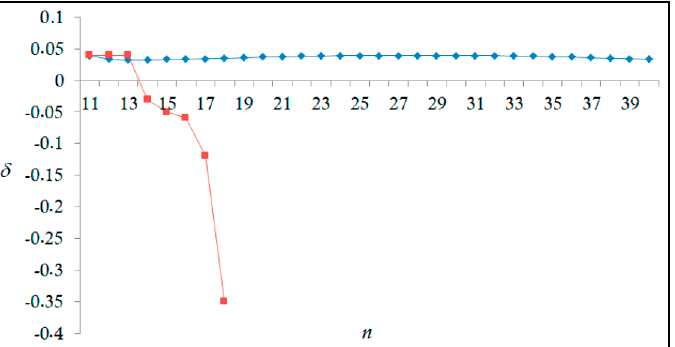
Figure 5. Variations of the quantum defect ( δ ) with the principal quantum number n for the 4 s 2 4 p 2 ( 3 P 2 ) nd Rydberg series originating from the 2 P ° 1/2 metastable state of Se + converging to the 3 P 2 series limits in Se 2+ .